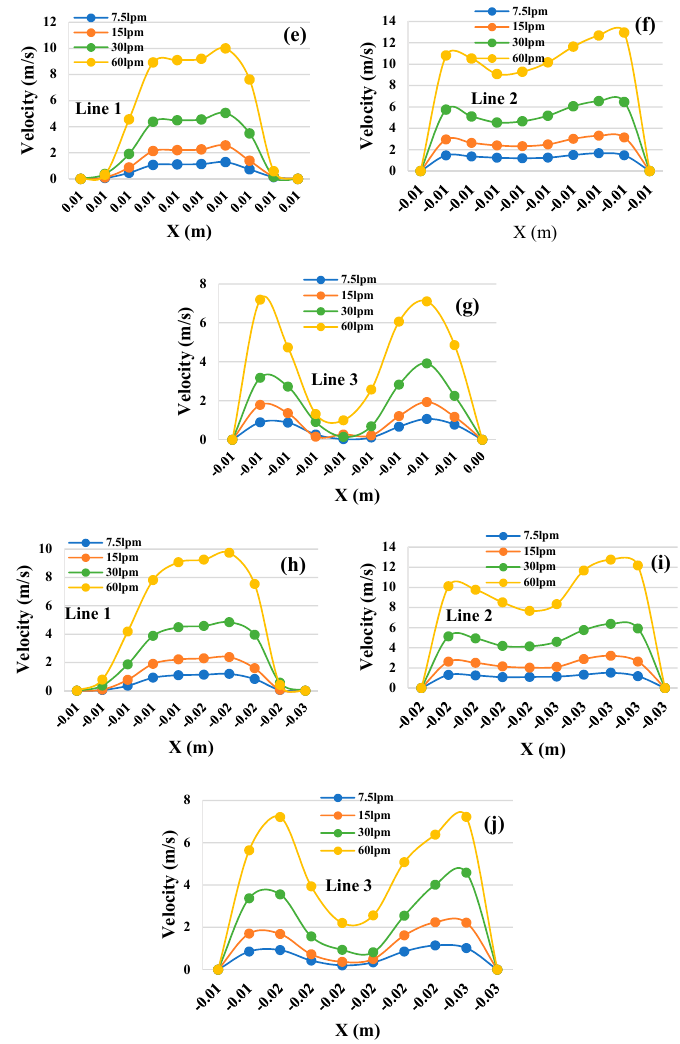
Figure 6. Velocity profiles for the three different lung sizes and for the four air flow rates at three selected cross-sections of the mouth-throat and trachea: ( a ) locations of cross-sections of the oral airways; velocity profile for 50-year-old lung ( b ) Line 1, ( c ) Line 2, ( d ) Line 3; velocity profile for 60-year-old lung ( e ) Line 1, ( f ) Line 2, ( g ) Line 3; velocity profile for 70-year-old lung ( h ) Line 1, ( i ) Line 2, and ( j ) Line 3.